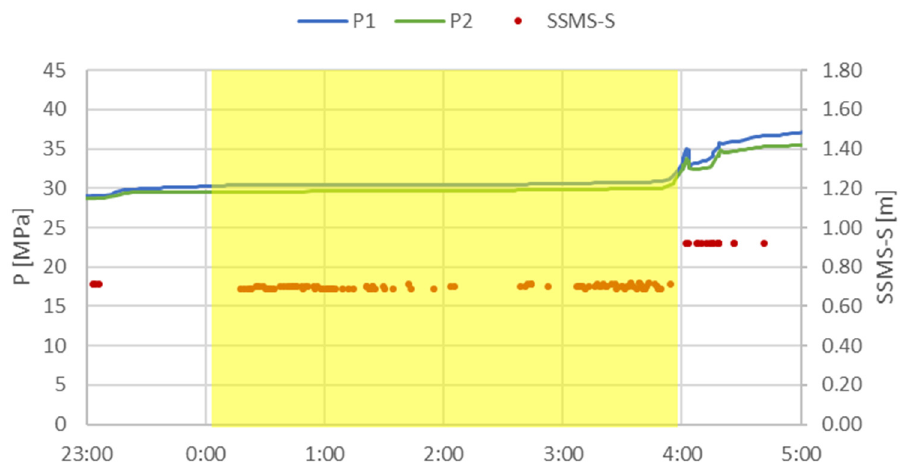
Figure 18. Fragment of the roof support work cycle (cycle No. 1).